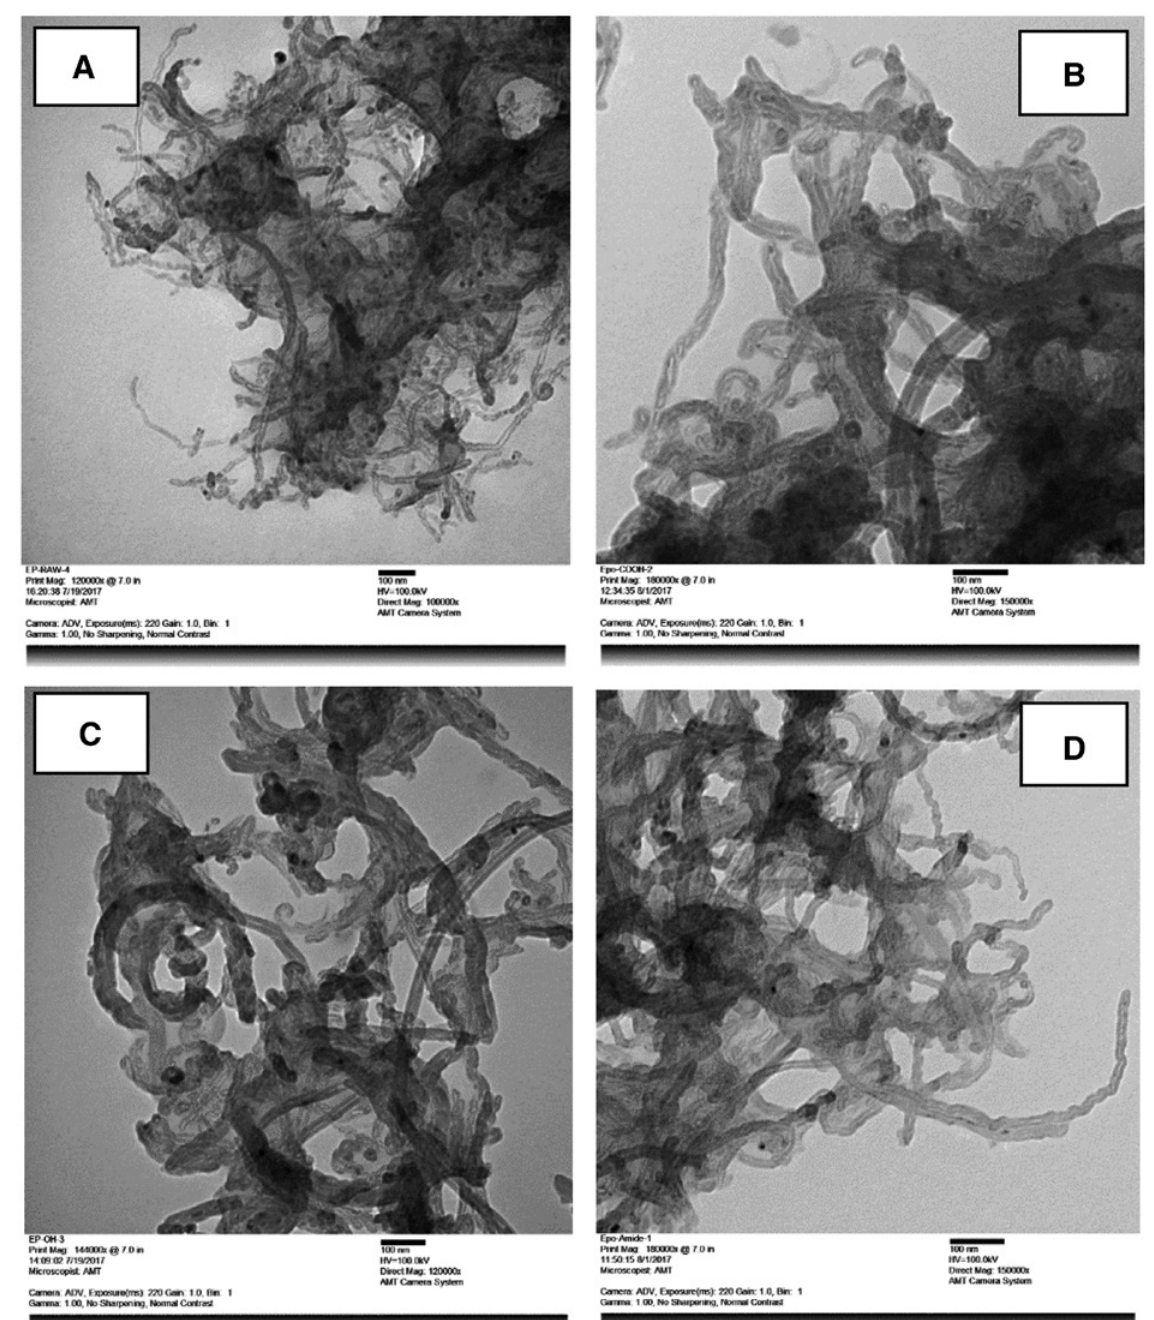
Figure 5: TEM images of (A) epoxy-CNTs-raw, (B) epoxy-CNTs-COOH, (C) epoxy-CNTs-OH, (D)